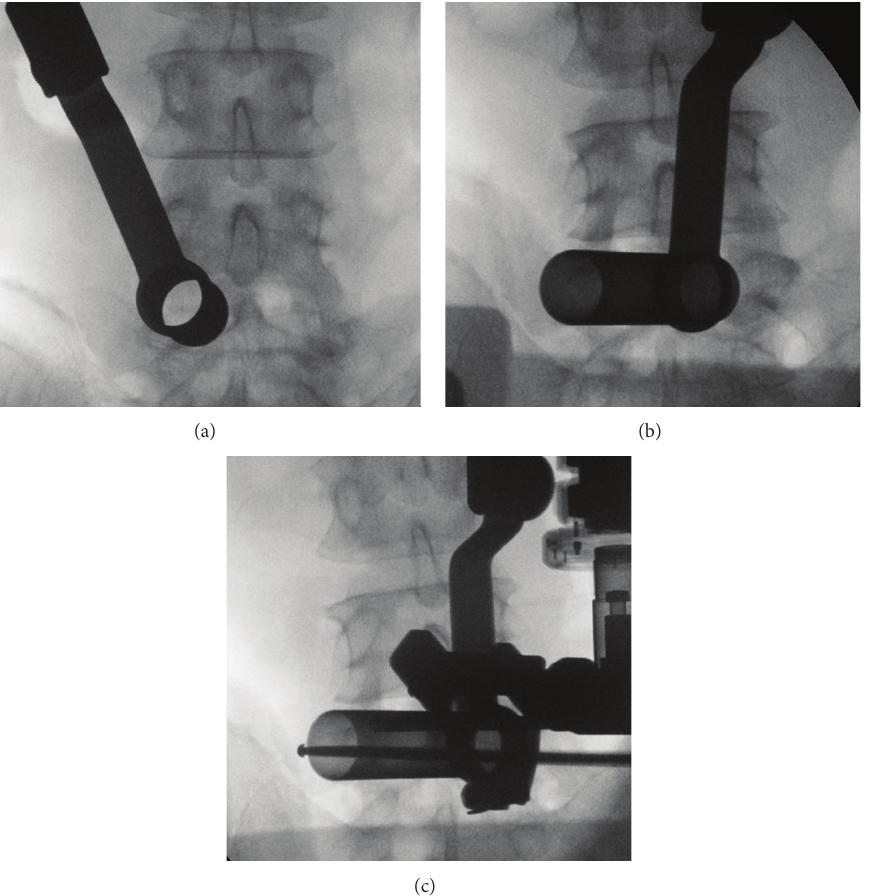
Figure 4: Intraoperative fluoroscopic images showing installation of the tubular retractor over the interlaminar space at left L4-5 for discectomy (a) and over the articulation for resection of the transverse process (b). The transverse process and sacral ala were resected with a high-speed burr